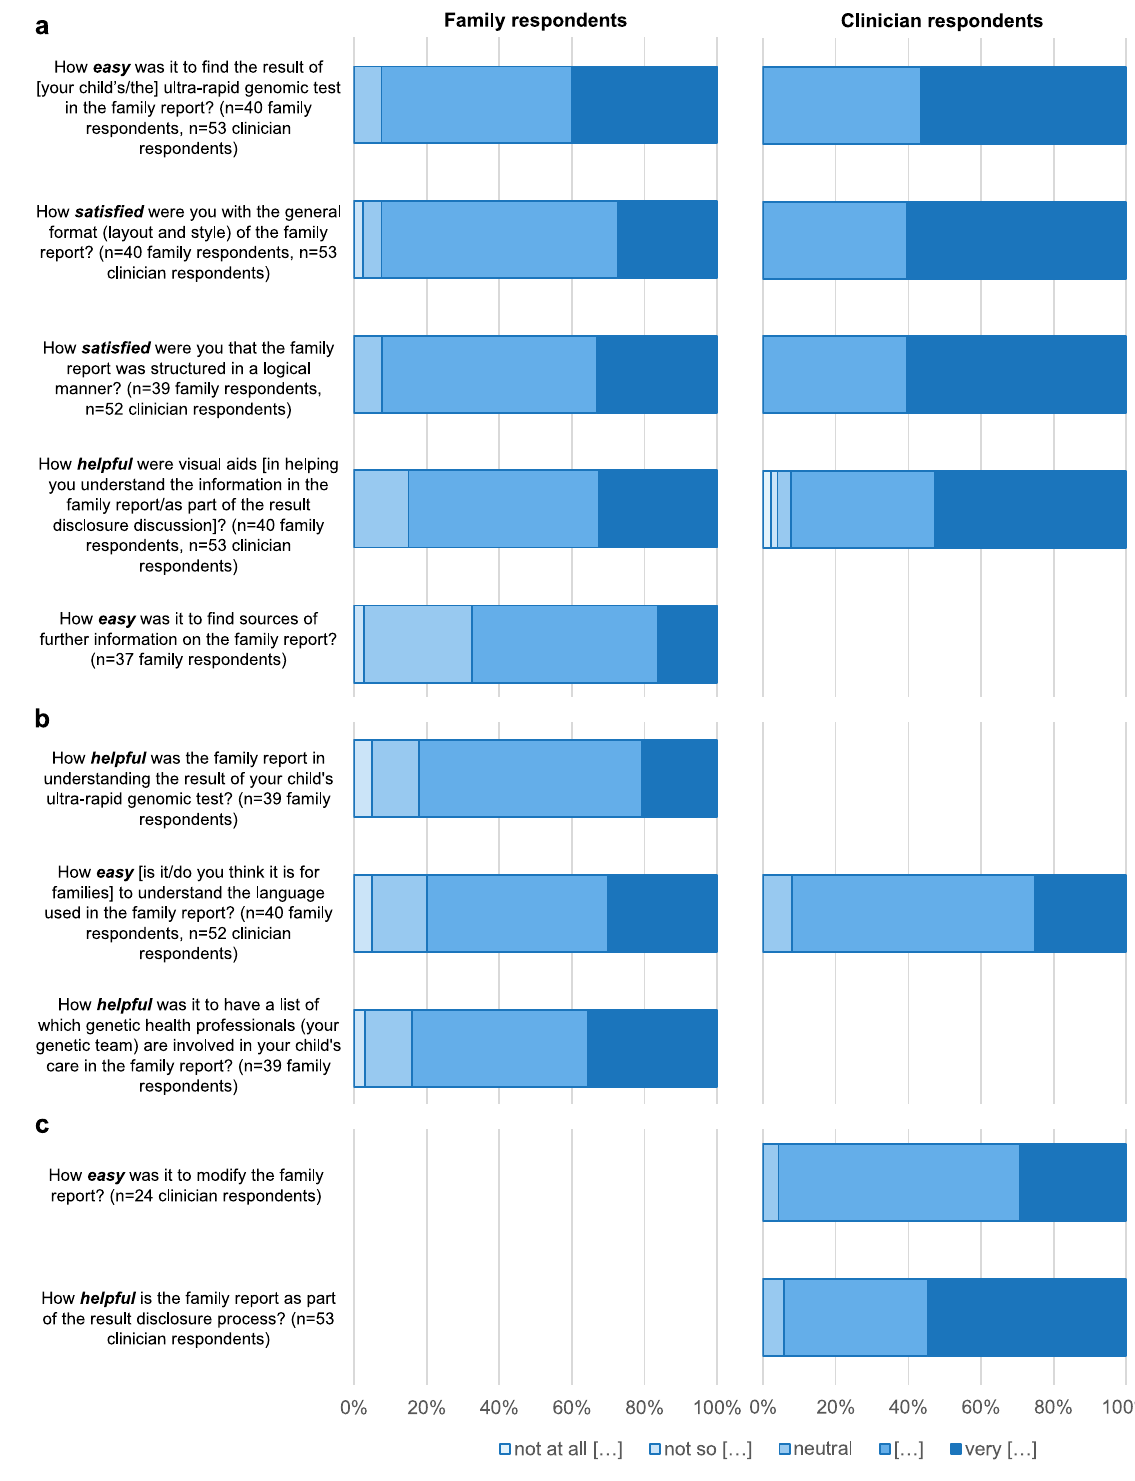
Fig. 2 Family and clinician responses to fi ve-point Likert scale questions. a Layout of “ family reports ” . b Content of “ family reports ” . c Use of “ family reports ” . The qualifying term represented by [ … ] in legend is in bold/italics within the respective